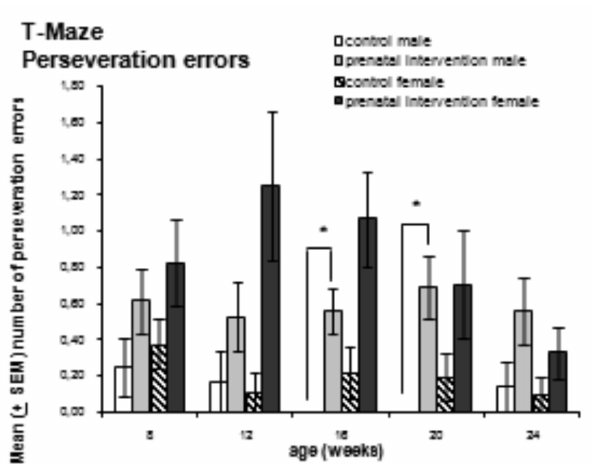
Figure 3 - T-Maze perseveration errors. The number of perseveration errors of male (n = 13-16) and female (n = 12-14) animals that received prenatal intervention, and that of male (n = 5-8) and female (n = 9-13) controls was measured at weeks 8, 12, 16, 20 and 24. Male and female animals that re- ceived prenatal intervention demonstrated a higher number of perseveration errors than the controls. These differences were significant for females at weeks 12 and 16, and for males at weeks 16 and 20; *p ≤